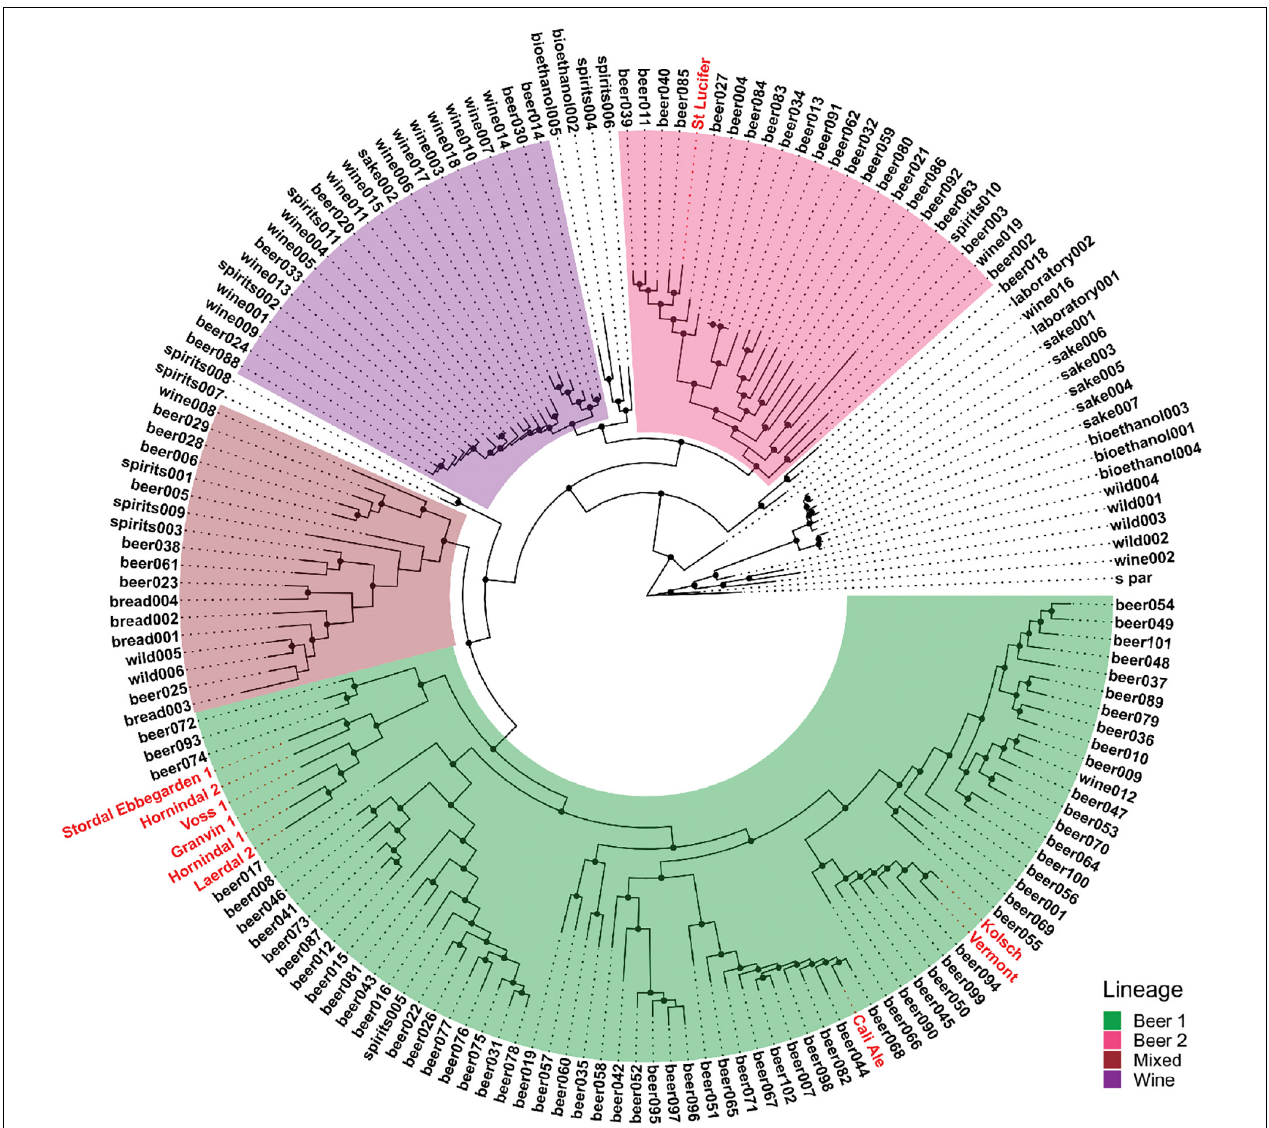
FIGURE 1 | Phylogeny of the strains used compared to the S. cerevisiae strains sequenced in Gallone et al. (2016). The four “main” lineages from Gallone et al. (2016) are color-coded and the strains used in this study are shown in